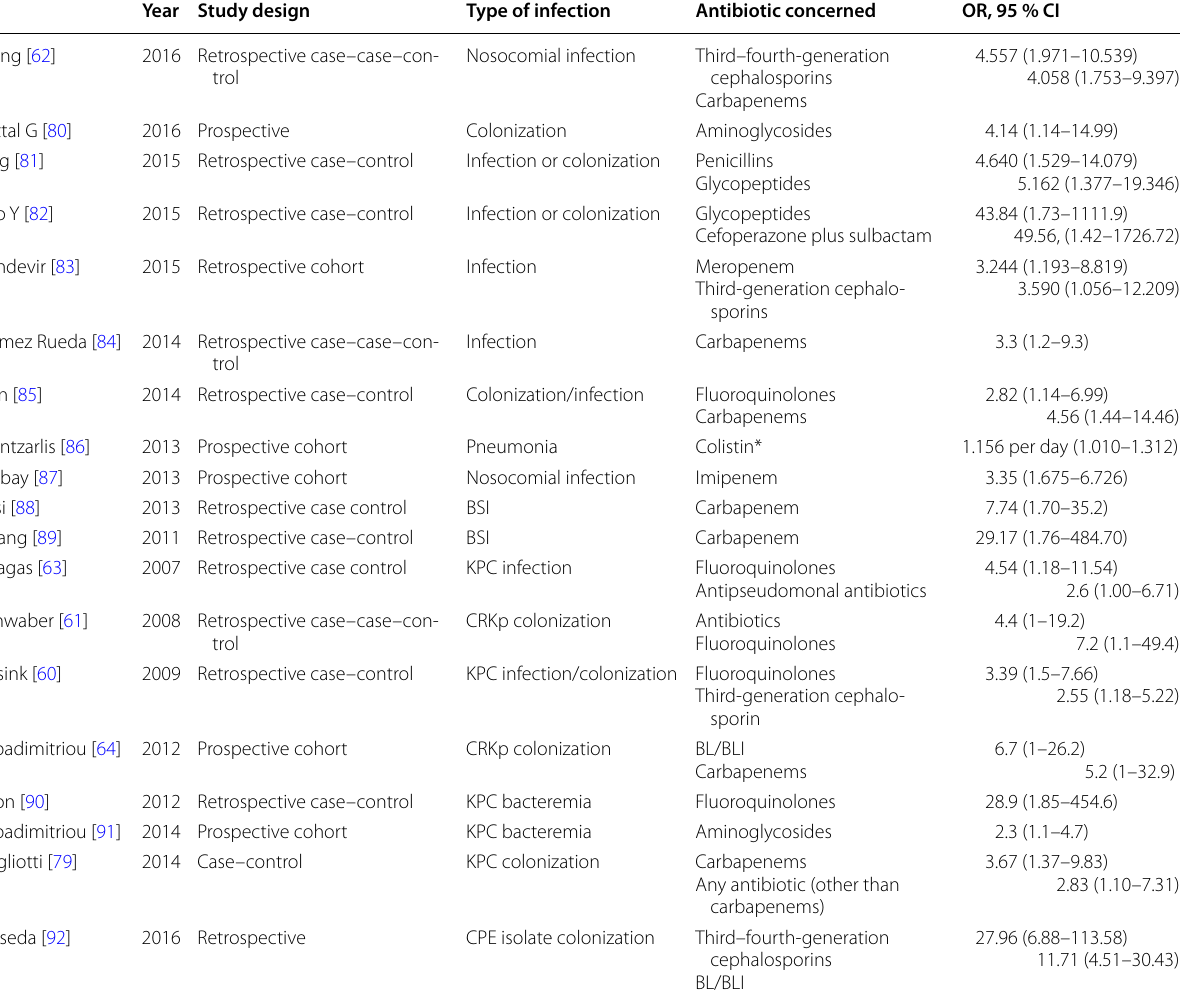
Table 2 Studies addressing the risk related to previous antibiotic therapy and emergence of carbapenem-resistant Enter-